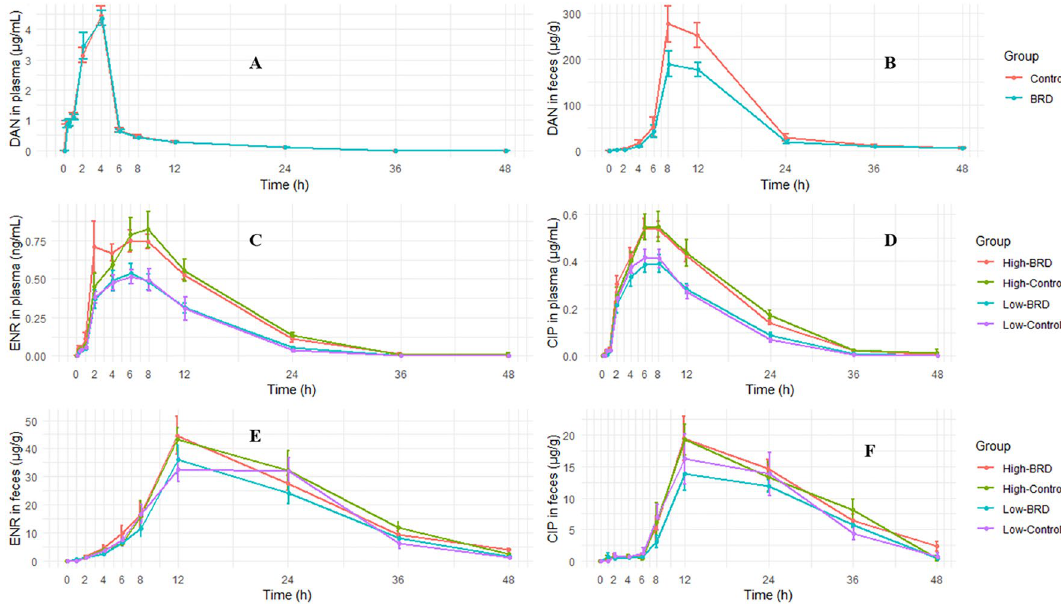
Figure 1. Concentration versus time plot of danofloxacin ( A DAN in plasma, B DAN in feces), enrofloxacin ( C ENR in plasma, E ENR in feces) and ciprofloxacin ( D CIP in plasma, F CIP in feces) in plasma and feces. The concentrations depicted in the graphs were the mean of all calves in a group at a given sampling time with the standard error (mean ± SE). None of the considered PK parameters were significantly different between healthy and BRD calves in plasma data, while some of the PK parameters derived from the fecal data (i.e., B ) were significantly different. Groups study 1 (Panels A and B ): Control—healthy calves injected danofloxacin (DAN, 8 mg/kg, n = 10) and BRD—calves infected with M. haemolytica and injected danofloxacin (DAN, 8 mg/ kg, n = 10); study 2 ( C – F ): High-BRD—calves infected with M. haemolytica and injected high dose enrofloxacin (ENR, 12.5 mg/kg, n = 7), High-Control—healthy calves injected high dose enrofloxacin (ENR, 12.5 mg/kg, n = 7), Low-BRD—calves infected with M. haemolytica and injected low dose enrofloxacin (ENR, 7.5 mg/kg, n = 7), and Low-Control—healthy calves injected low dose enrofloxacin (ENR, 7.5 mg/kg, n =